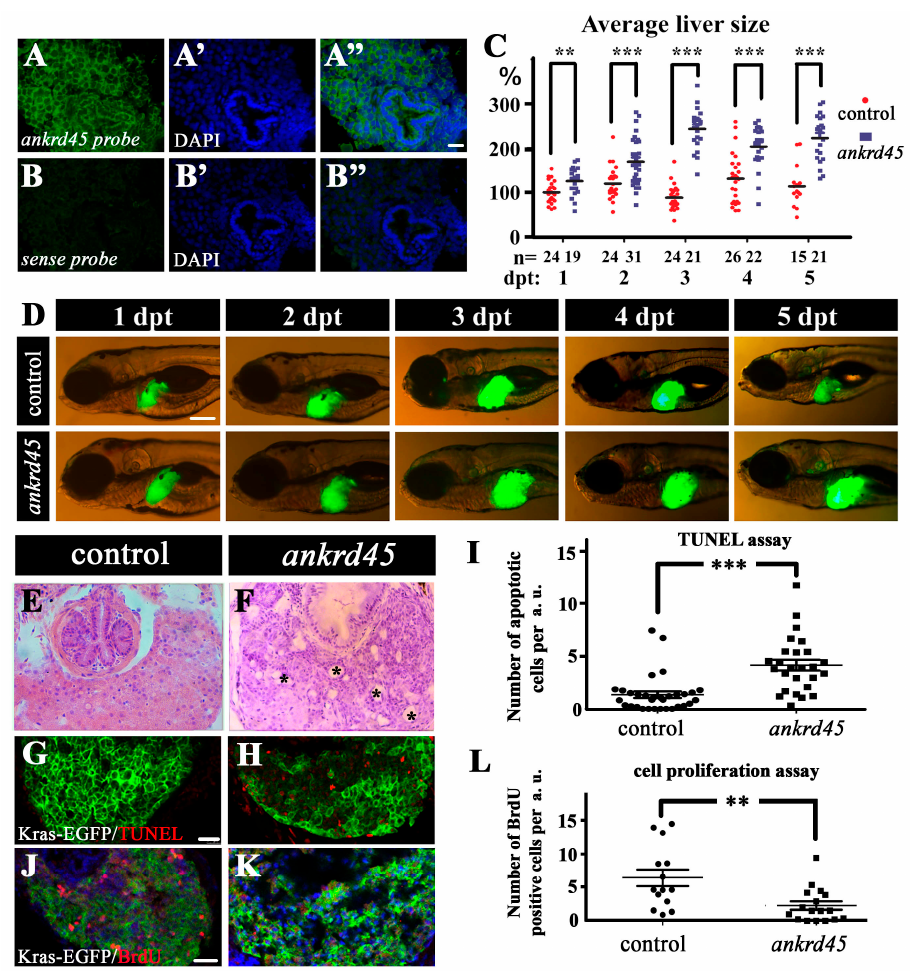
Figure 2. Liver-specific induction of Kras G12V results in larger livers in ankrd45 mutants. ( A–B’’